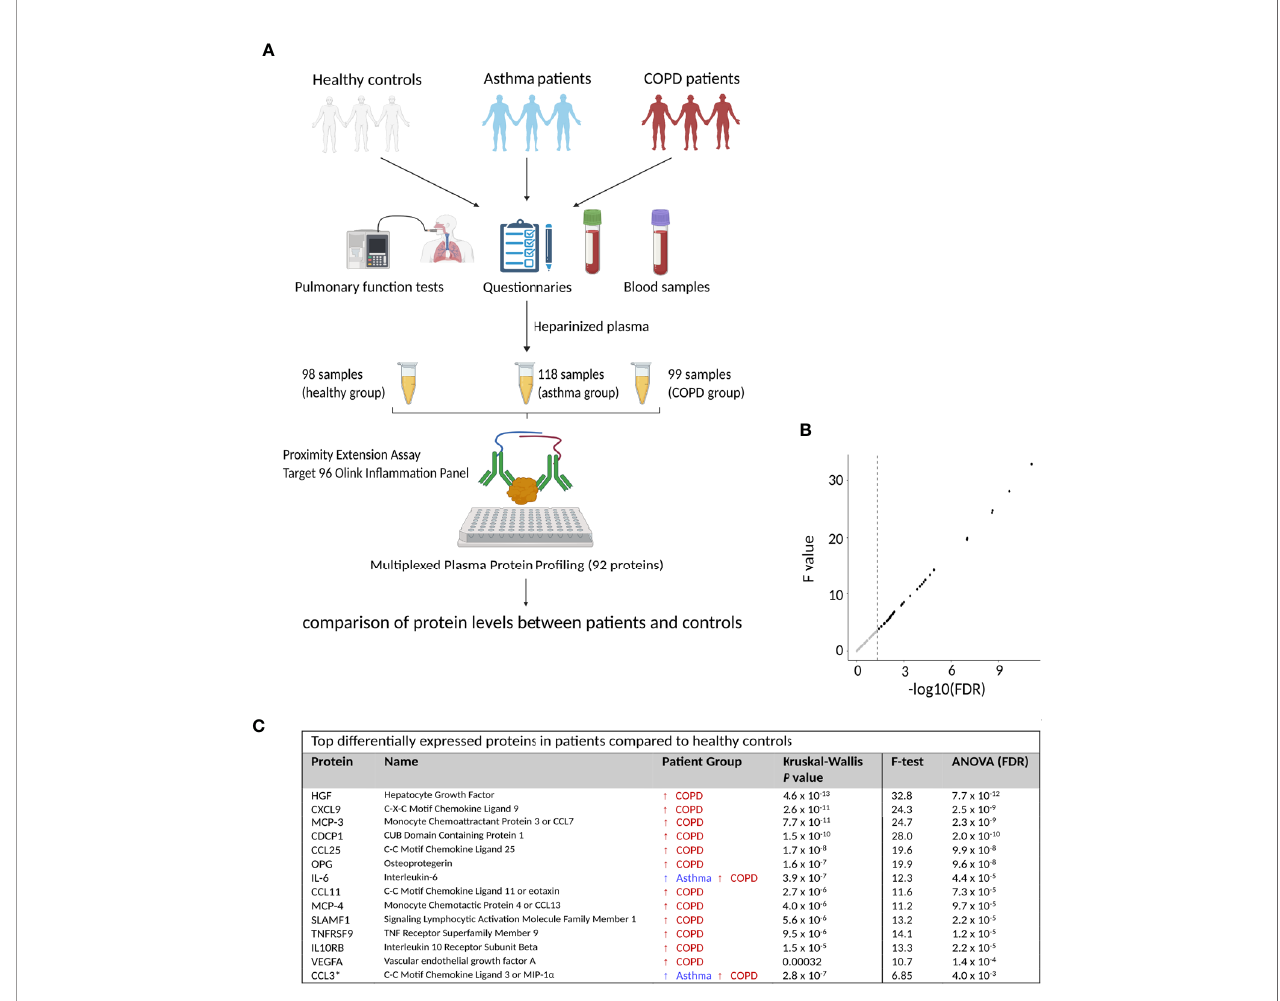
FIGURE 1 | Identi fi cation of differentially expressed proteins in COPD. (A) Schematic representation of study groups and samples included in the proteomic screening. (B) Dot plot on the F value versus the False Discovery Rate (FDR) for all measured proteins. Dotted lines represent P = 0.05. (C) Top differentially expressed proteins by comparing asthma and COPD patients with healthy controls. Detailed information on protein names and P values is presented in Supplementary Table 1 . This fi gure was drawn using